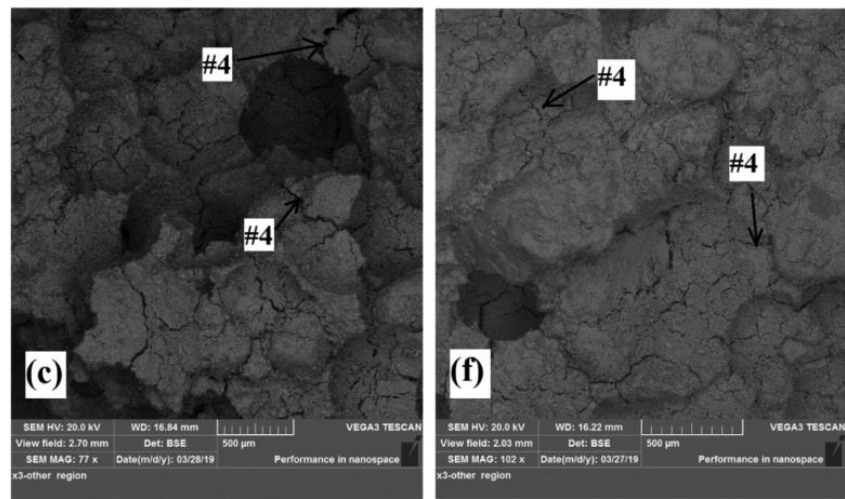
Figure 1. SEM images of fracture surfaces of control and modified mortar [28] (Reprinted/adapted with permission from Ref. [28]. Copyright 2018, ELSEVIER); ( a ) control at 25 ◦ C, ( b ) control at 250 ◦ C, ( c ) control at 900 ◦ C, ( d ) NCMC mortar at 25 ◦ C, ( e ) NCMC mortar at 250 ◦ C, ( f ) NCMC mortar at 900 ◦